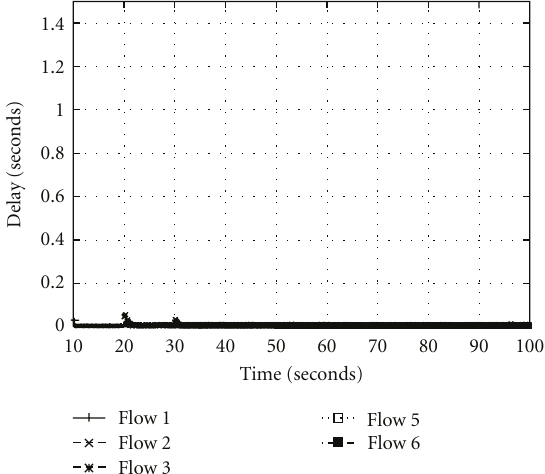
Figure 13: Delay of six flows versus time when IAC/O is employed. RTS/CTS mechanism is used.